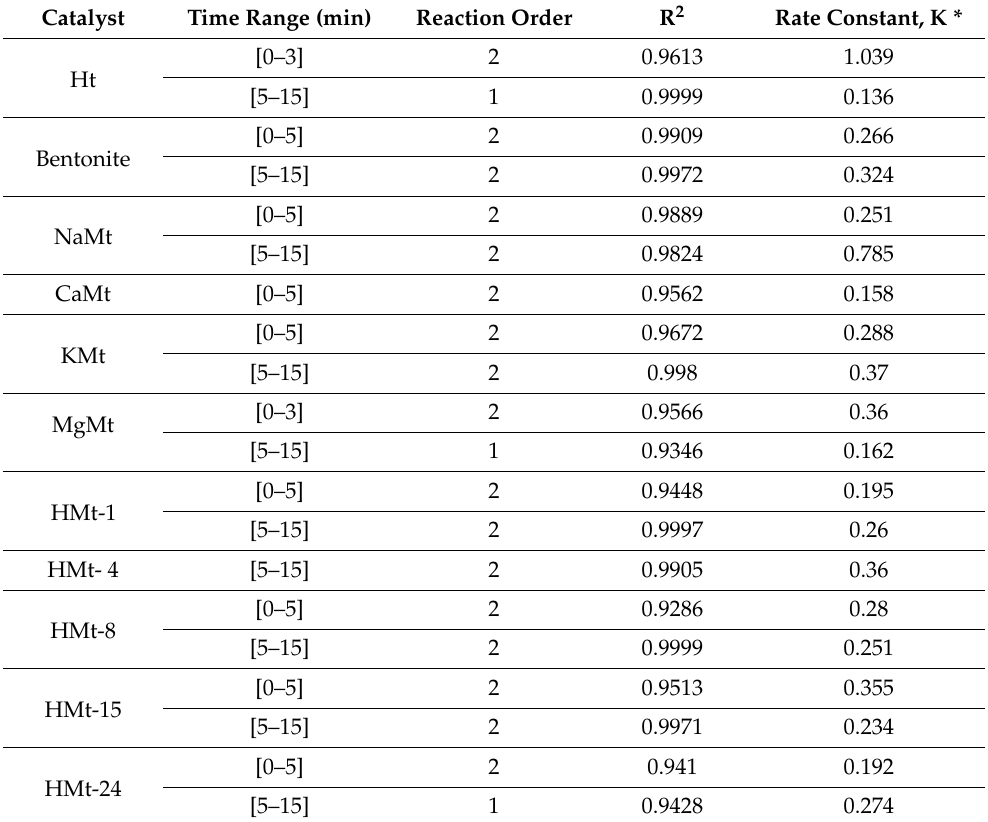
Table 3. Most probable reaction orders and rate constants for ozonation with different